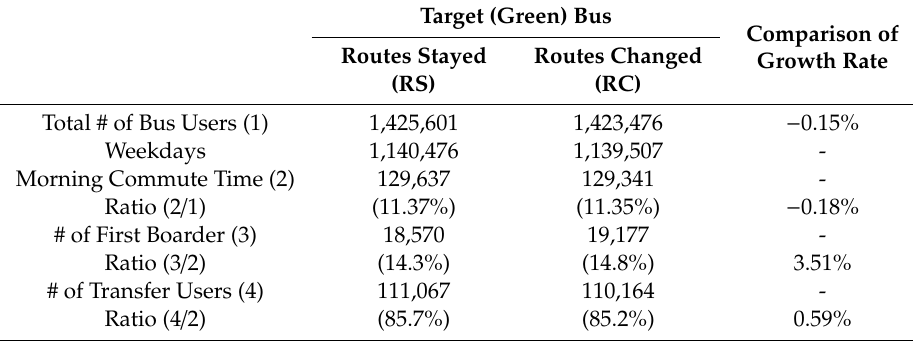
Table 5. Period before route change (four months, January–April, in